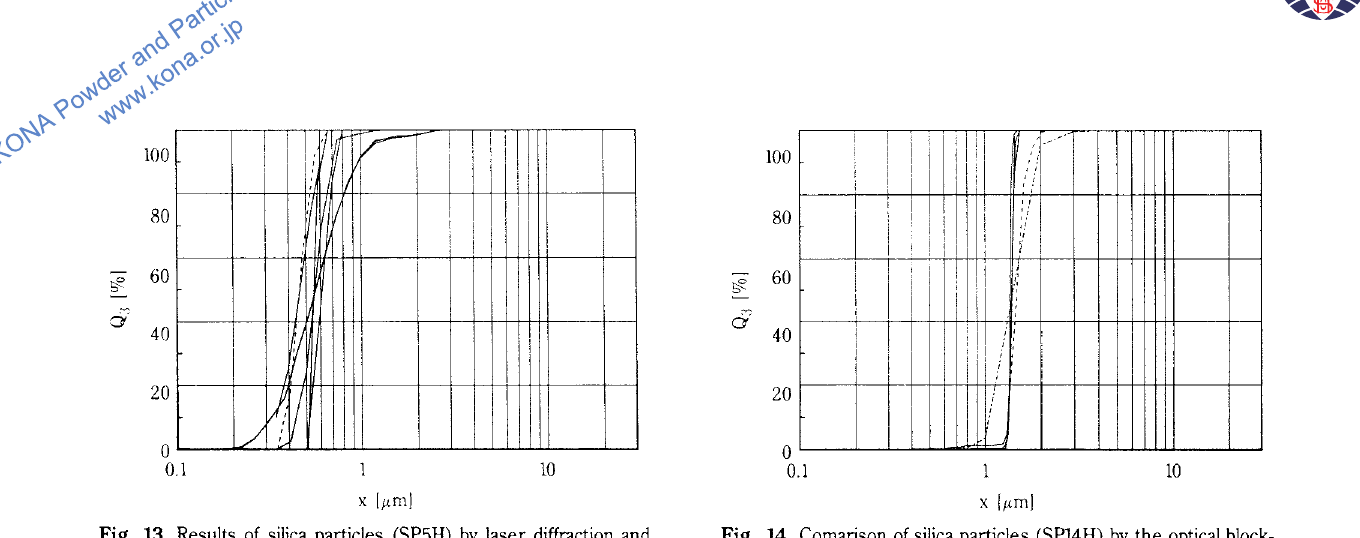
Fig. 14 Comarison of silica particles (SP14H) by the optical block age method (single dot chain lilne), electrical sensing zone method (dooted line), and image analysis method (solid line: 3